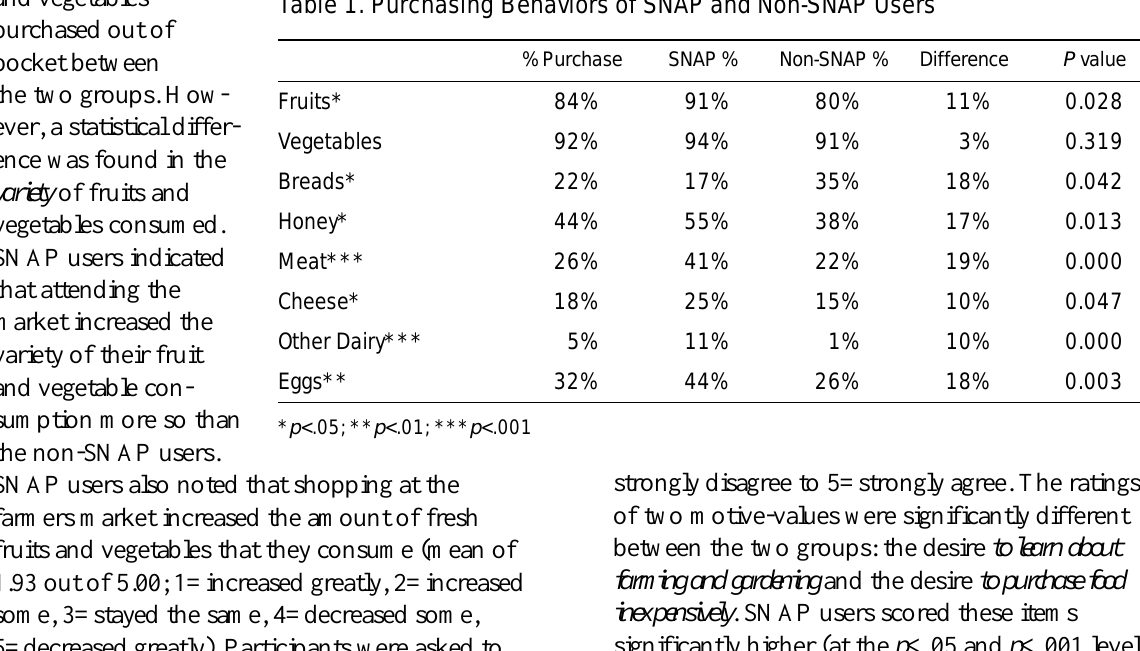
Table 1. Purchasing Behaviors of SNAP and Non-SNAP